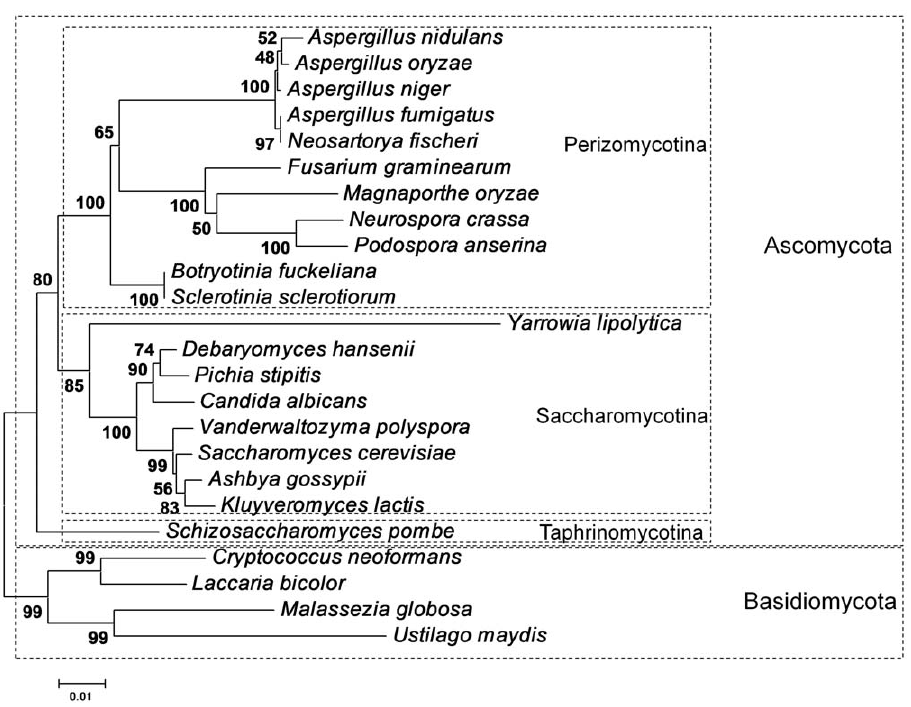
Figure 1. Phylogenetic relationships among the fungal species used in this analysis. Phylogenetic analysis was performed based on 1276 nucleotide sites of 18S rRNA gene without the gap/insertion sites. The neighbor-joining tree was reconstructed using the MEGA software [21]. The bootstrap was performed with 1000 replicates. The rate variation among sites was considered with gamma distributed rate ( a =1). The other default parameters were not changed. (Fig. 2). After Ascomycota and Basidiomycota were branched off in the course of fungal evolution, Taphrinomycotina (‘‘Archiasco- mycetes’’) diverged prior to the separation of Saccharomycotina (‘‘Hemiascomycetes’’) and Perizomycotina (‘‘Euascomycetes’’) in the Ascomycota lineage [15–17]. Therefore, Saccharomycotina is phylogenetically more closely related to Perizomycotina than Taphrinomycotina. Why only Perizomycotina has introns in the histone genes of Ascomycota? We have no idea whether filamentous growth and yeast growth are related to presence and absence of introns in the histone genes of Ascomycota respectively or not. Because the basidomycetous yeast Cryptococcus neoformans has introns in its histone genes (Fig. 2). The bias of the intron distribution is not limited in the histone genes but also in the other genes [12].